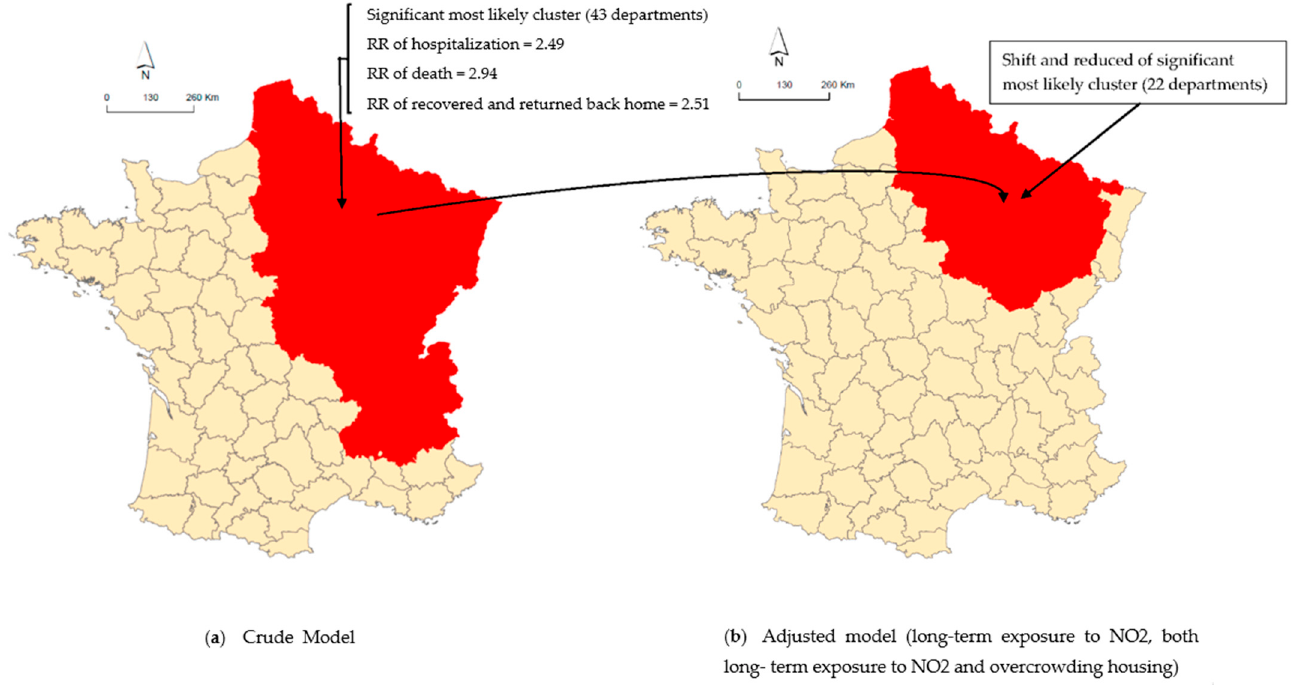
Figure 5. Mapping of a spatial display of incidence of COVID-19 related outcome (Hospitalization death in the hospital, recovered, and returned back home): ( a ) crude model, ( b ) adjusted model on long-term exposure to NO 2 , and both long-term exposure to NO 2 and overcrowded housing. Table 3. Summary statistics of the most likely clusters of COVID ‐ 19 ‐ related outcomes and spatial relocation resulting from the adjustment analysis.